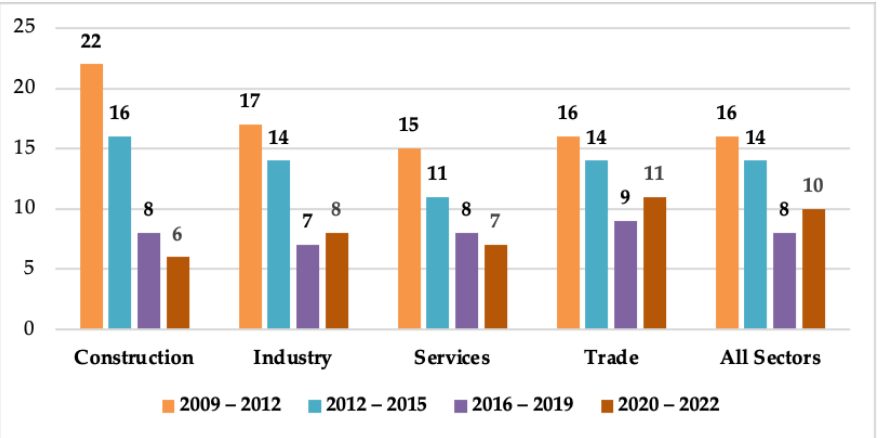
Figure 5. Most relevant issues encountered by euro area SMEs throughout industries (access to finance — weighted percentage of surveyed). Source: Adapted from Ref. [77].